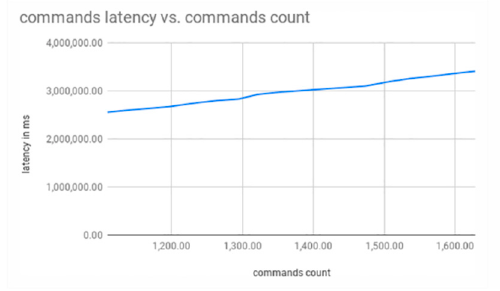
Figure 13. Commands latency curve versus the command operations count.